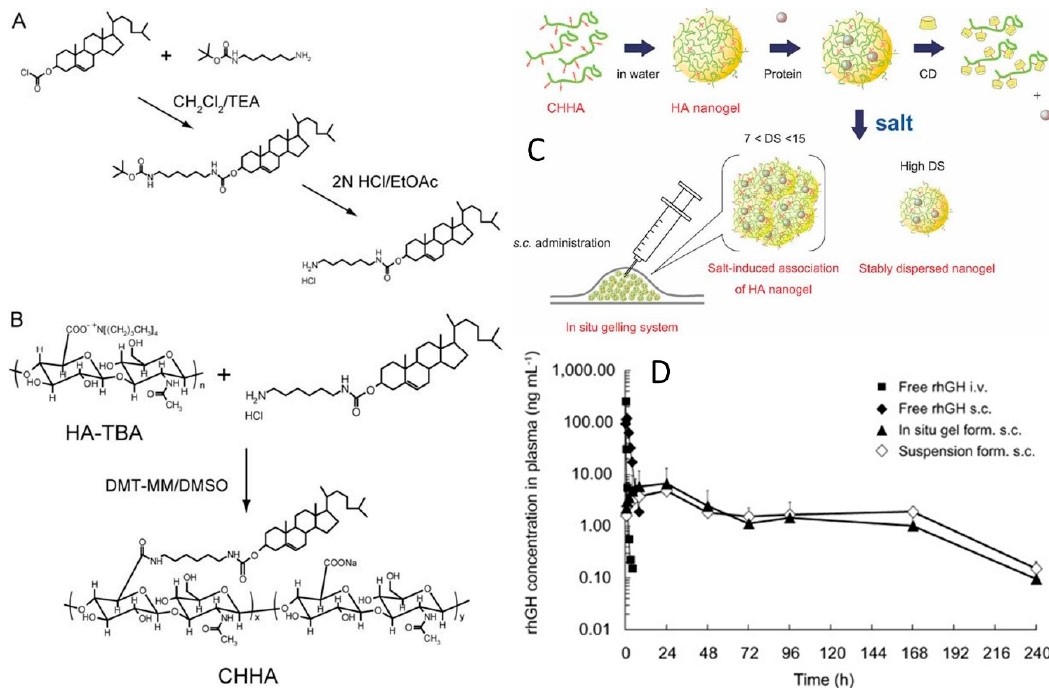
Figure 9. Synthesis of ( A ) cholesteryl-6-aminohexylcarbamate and ( B ) cholesteryl-group-bearing HA or CHHA, ( C ) schematic illustration of HA nanogels and solution properties, ( D ) pharmacokinetic study of HA nanogel formulation in rat. In situ gel formulation (solution state) and suspension formulation were injected subcutaneously into rats with a 25-gauge needle at a dose of 1.9 mg kg − 1 . Non-treated rhGH was also injected both intravenously at a dose of 0.1 mg kg − 1 and subcutaneously at a dose of 0.5 mg kg − 1 . rhGH levels in plasma were determined using an ELISA. TEA: trimethylamine, HA-TBA: HA-TBA: Tetrabutylammonium salts of HA, DS: degree of substitution From [65].